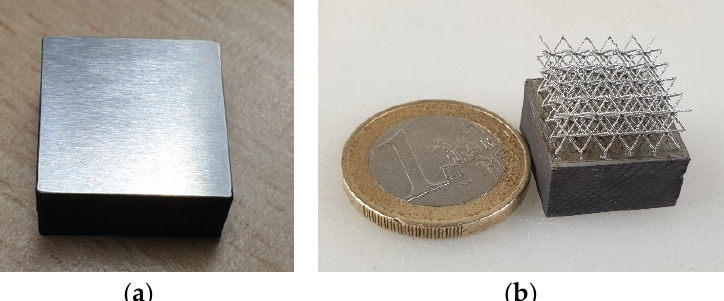
Figure 13. NiTi fabricated samples: ( a ) Substrate of 17 × 17 × 10 mm 3 produced by FFF technology and ( b ) Hybrid structure including LPBF part (bcc lattice structure of 12 × 12 × 6 mm 3 ) built on FFF part.